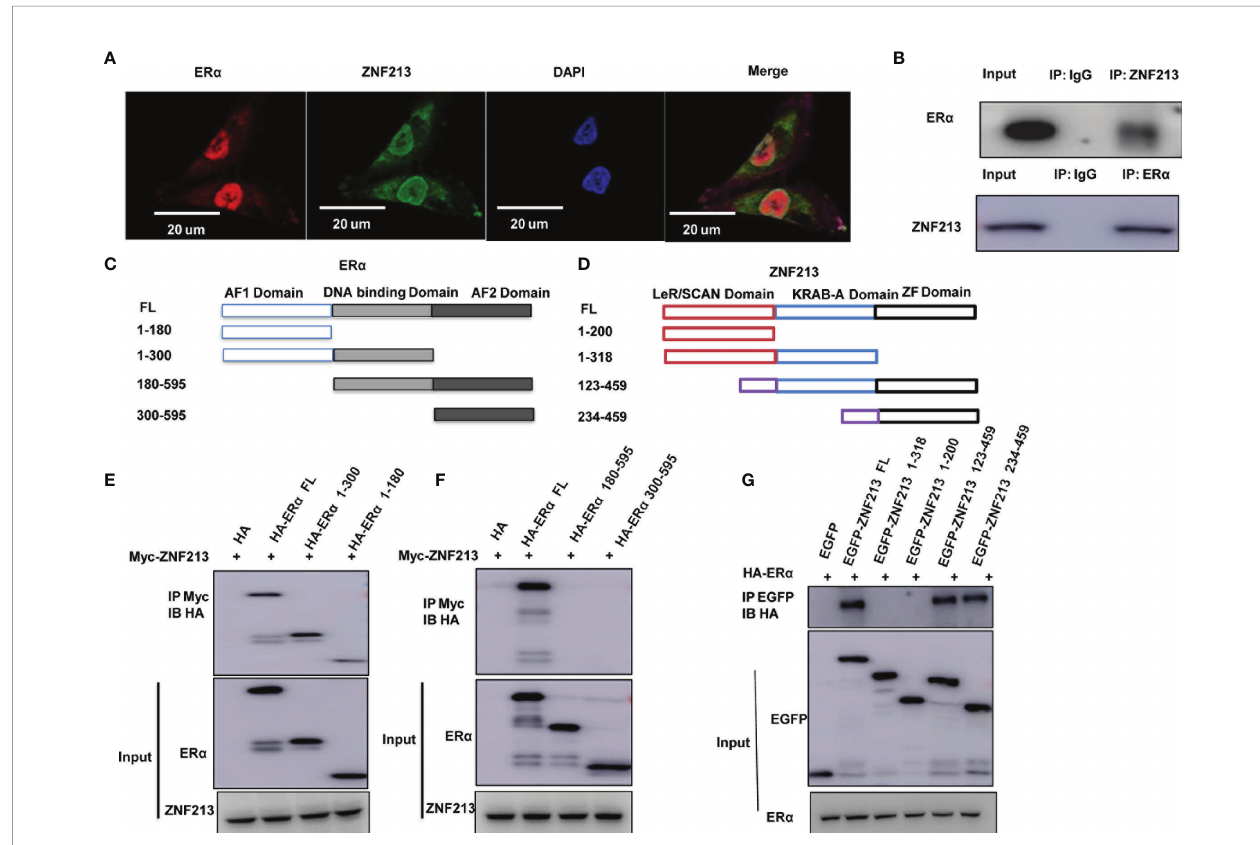
FIGURE 4 | ZNF213 could associate with ER alpha in breast cancer cells (A) Intracellular localization analysis of ZNF213 and ER alpha by immuno fl uorescence assay. MCF7 cells were cultured in normal medium before fi xation. Intracellular localization of ER alpha (green) and ZNF213 (red) were shown. Nuclei (blue) were stained with 4 ’ ,6-diamidino-2-phenylindole (DAPI). (B) Co-IP assay reveals association between endogenous ZNF213 and ER alpha in MCF7 cells. MCF-7 cells were harvested with RIPA lysis buffer. CO-IP was performed using antibody as indicated. (C) ER alpha domain structure and deletion mutants used in the study (Full length, D AF1, D AF1+ D DBD, D AF2, D AF2+ D DBD). (D) ZNF213 full length and deletion mutants are used in the study (Full length, D ZF domain, D LeR/SCAN domain, D ZF+ D KRAB-A domain). (E, F) AF1 domain is required for ER alpha to interact with ZNF213 (G) ZF domain is required for ZNF213 to interact with ER